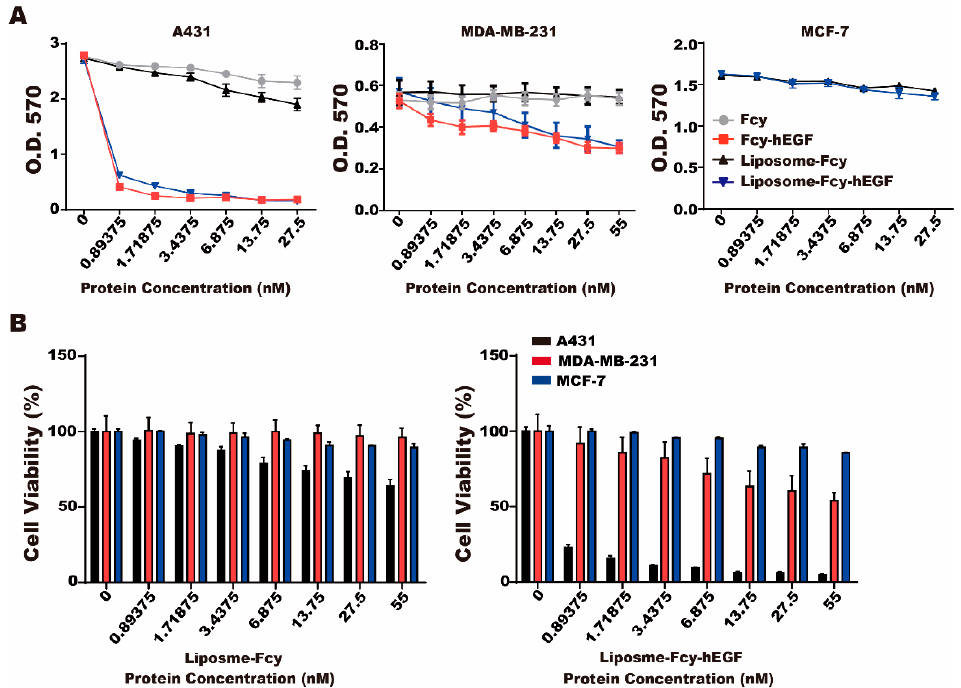
Figure 3. Cytotoxicity of liposome-Fcy-hEGF/5-FC and liposome-Fcy/5-FC. ( A ) MTT assay was conducted for A431 (left), MDA-MB-231 (middle) and MCF-7 (right) cells treated with different concentration of liposome-Fcy-hEGF, liposome-Fcy, Fcy-hEGF and Fcy in combination with 5-FC (1 mg/mL). ( B ) Percentage of viable A431, MDA-MB-231 and MCF-7 cells treated with different concentration of liposome-Fcy-hEGF (right) and liposome-Fcy (left) in combination with 5-FC (1 mg/mL). The data are means ± SEM of three independent experiments performed in triplicate.